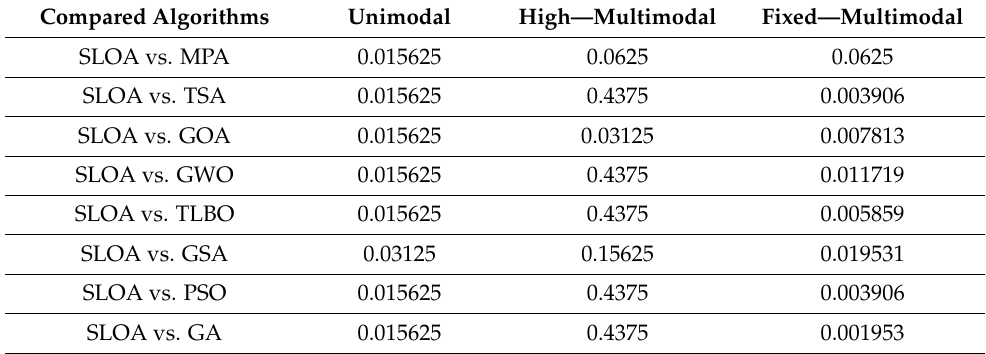
Table 5. Obtained results from the Wilcoxon test ( p ≥